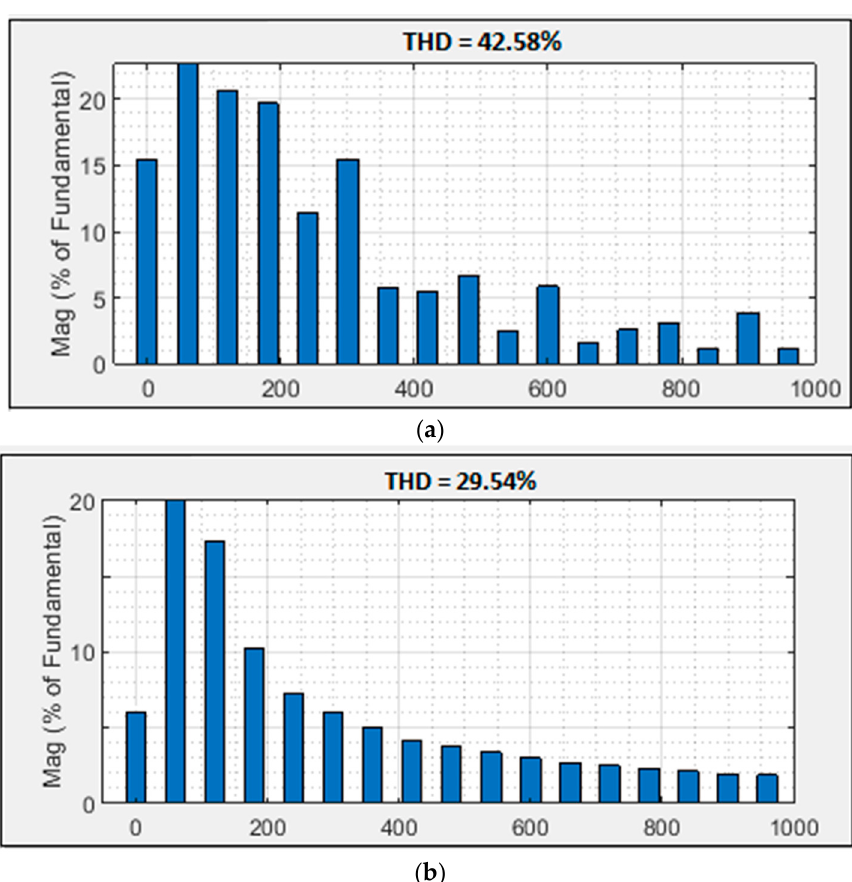
Figure 12. Voltage harmonics at PCC ( a ) Hybrid with MC, ( b ) Hybrid with MC and SVC.